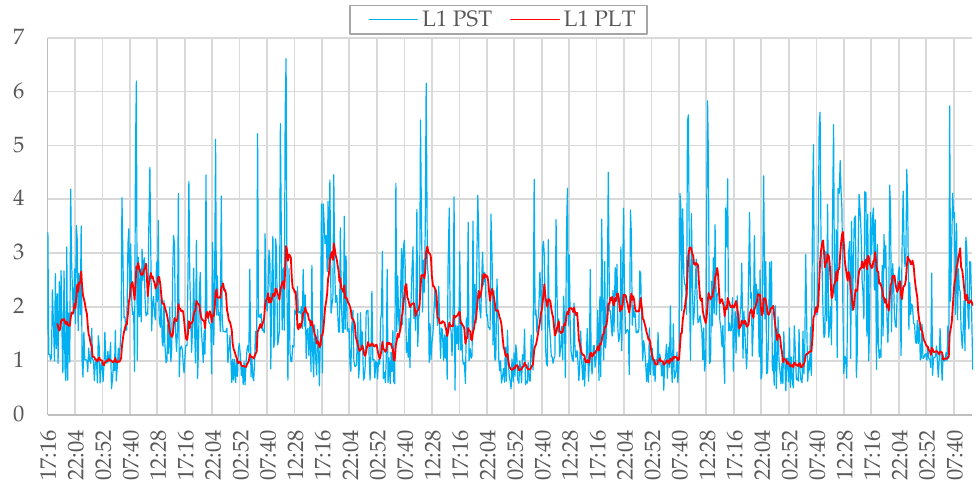
Figure 8. Voltage measurements according to standard EN 50160 at Object 1 (three phases, average of 10-min intervals).